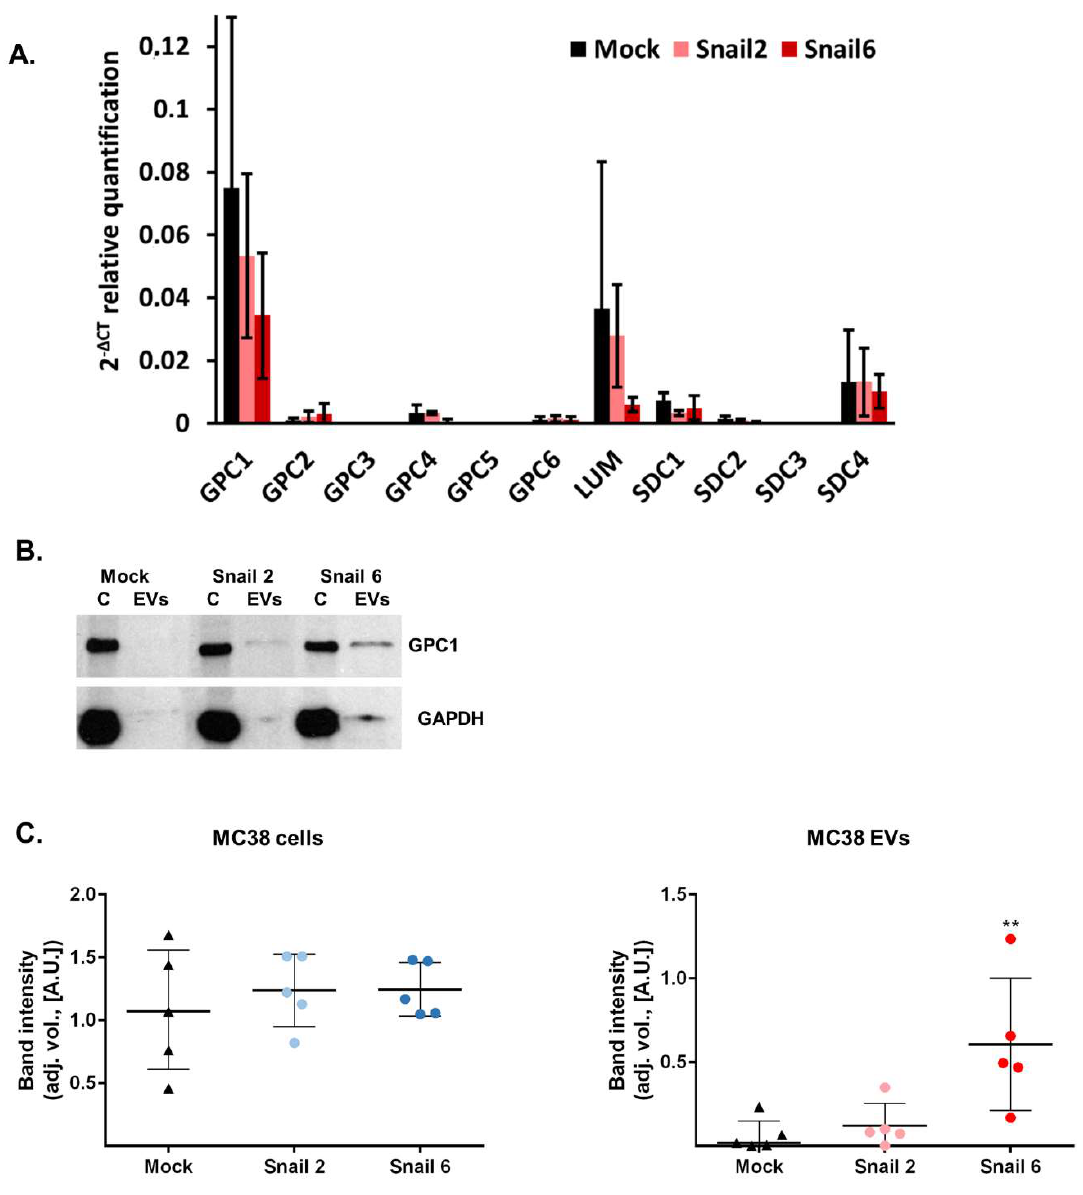
Figure 4. Proteoglycans gene expression in EVs of Mock and Snail-overexpressing MC38 cells. ( A ) Real-time RT-PCR analysis of proteoglycans expression in Mock-MC38- and Snail-MC38-derived EVs; n ≥ 3. ( B ) Western blot analysis of Glypican-1 (GPC1) expression in cell lysates (C) from Mock- and Snail-MC38 cells and corresponding EVs. ( C ) Densitometry analysis of protein bands. For both MC38 cells and EVs: adjusted volume (adj. vol.) of GPC1 band was quantified by ImageLab ® from Biorad ( n = 4, ** p < 0.01).